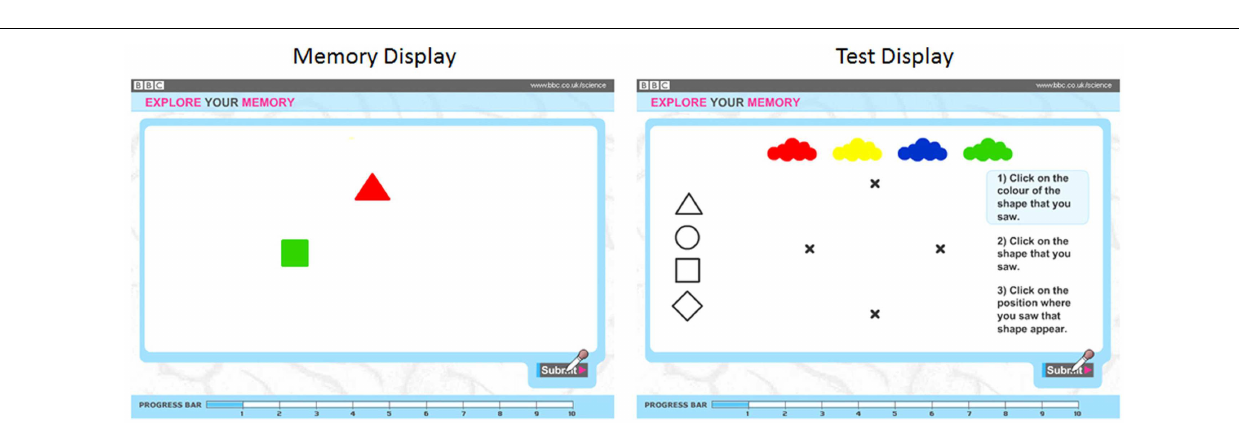
FIGURE 1 | Sample demographics broken down by age, gender, and education.